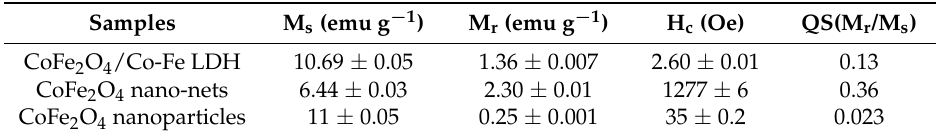
Table 1. Magnetic data for the cobalt ferrite-supported LDH, cobalt ferrite nano-nets, and cobalt ferrite